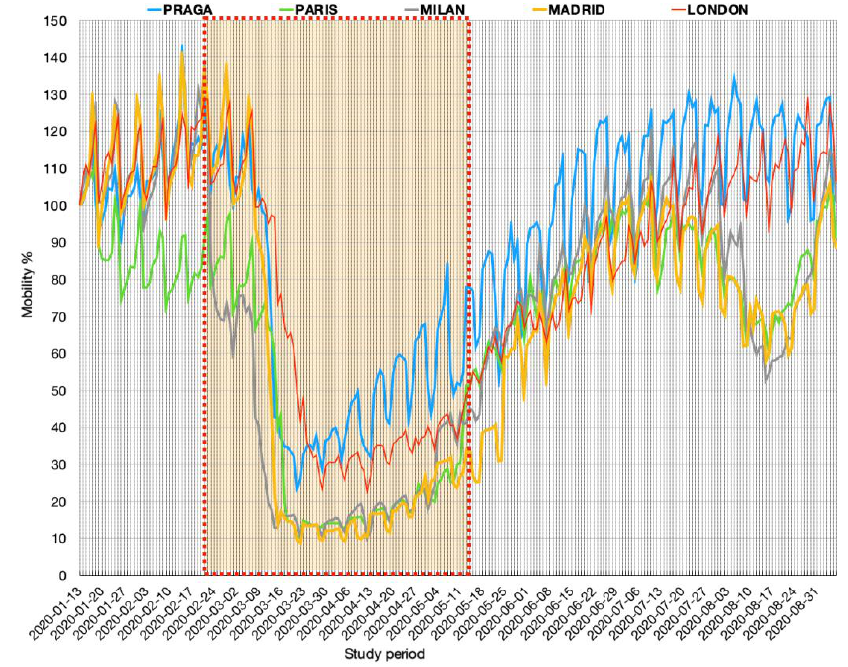
Figure 1. Driving mobility evolution in European cities from January 2020 until September 2020. Source: Own elaboration with data collected from Apple ’s mobility trend [22].